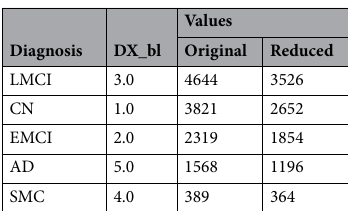
Table 2. Original versus reduced targets’